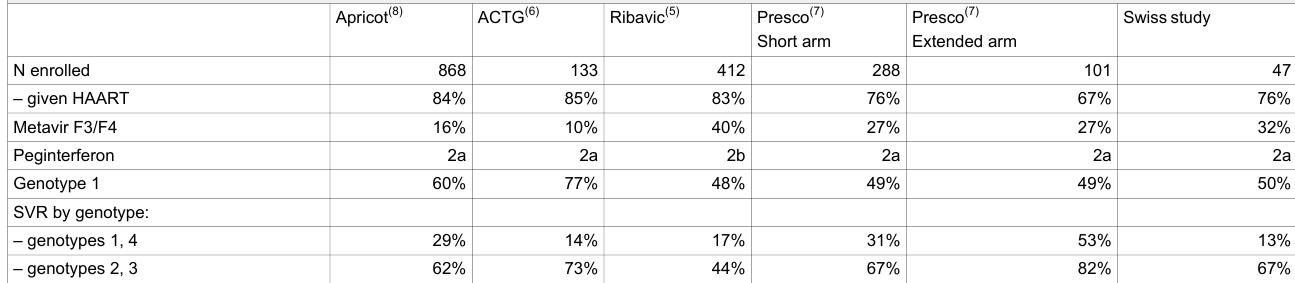
Table 7 SVR in four pivotal studies on treatment of HCV in HIV-HCV co-infected patients; comparison with the Swiss